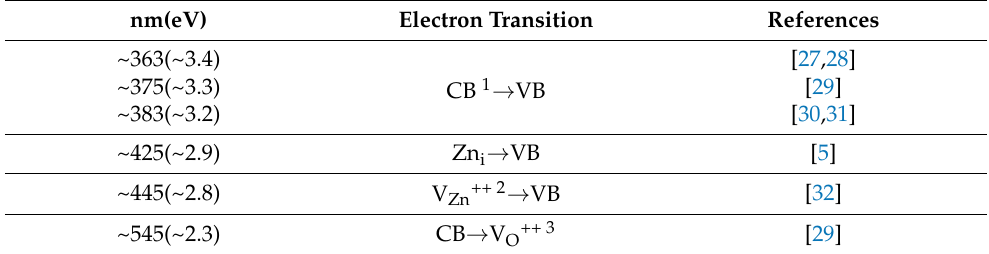
Table 1. Possible origin of emission peaks in PL spectra of ZnO/ h -BN